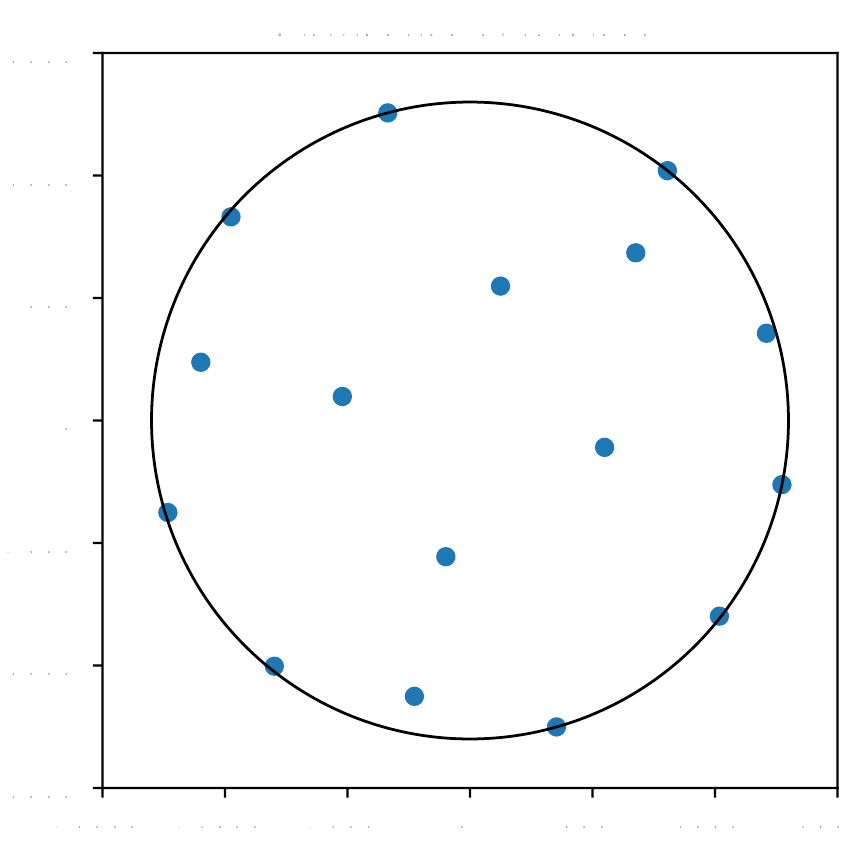
Figure 6. Turbine layout by means of DPCRO-SL (16 turbines, 1300m